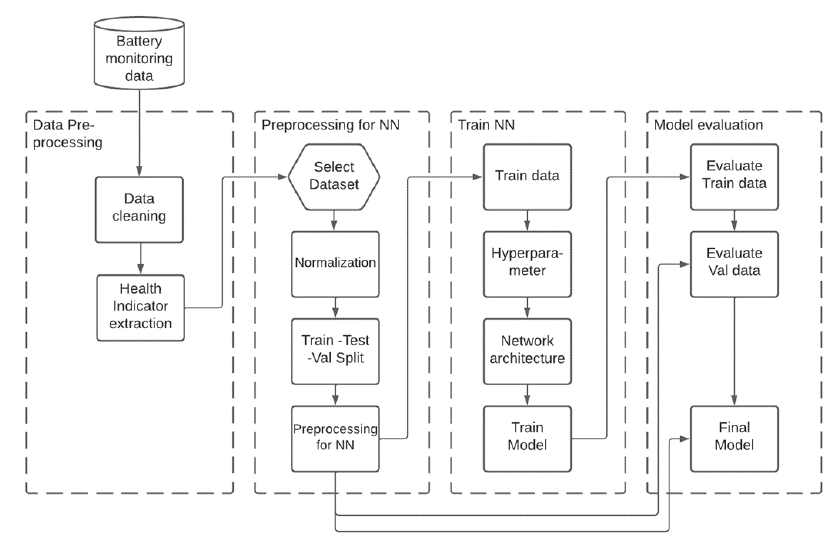
Figure 6. Flowchart for SOH